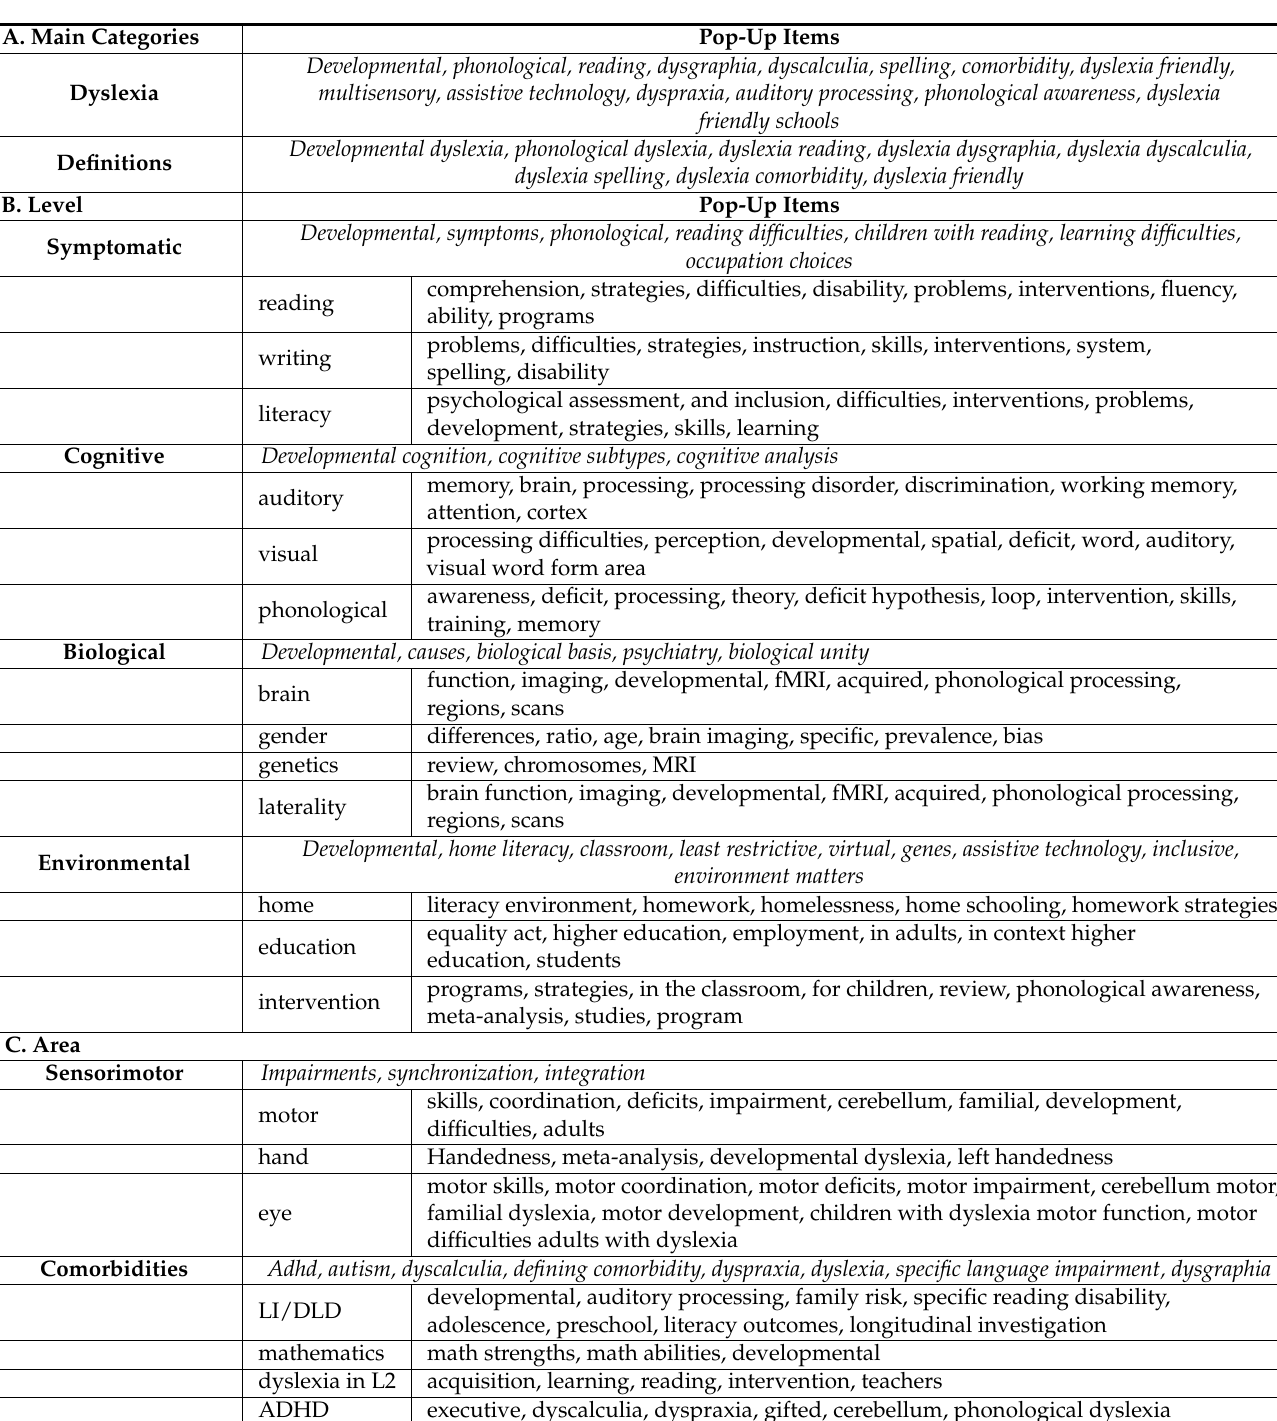
Table 1. Search words. Main categories, levels and